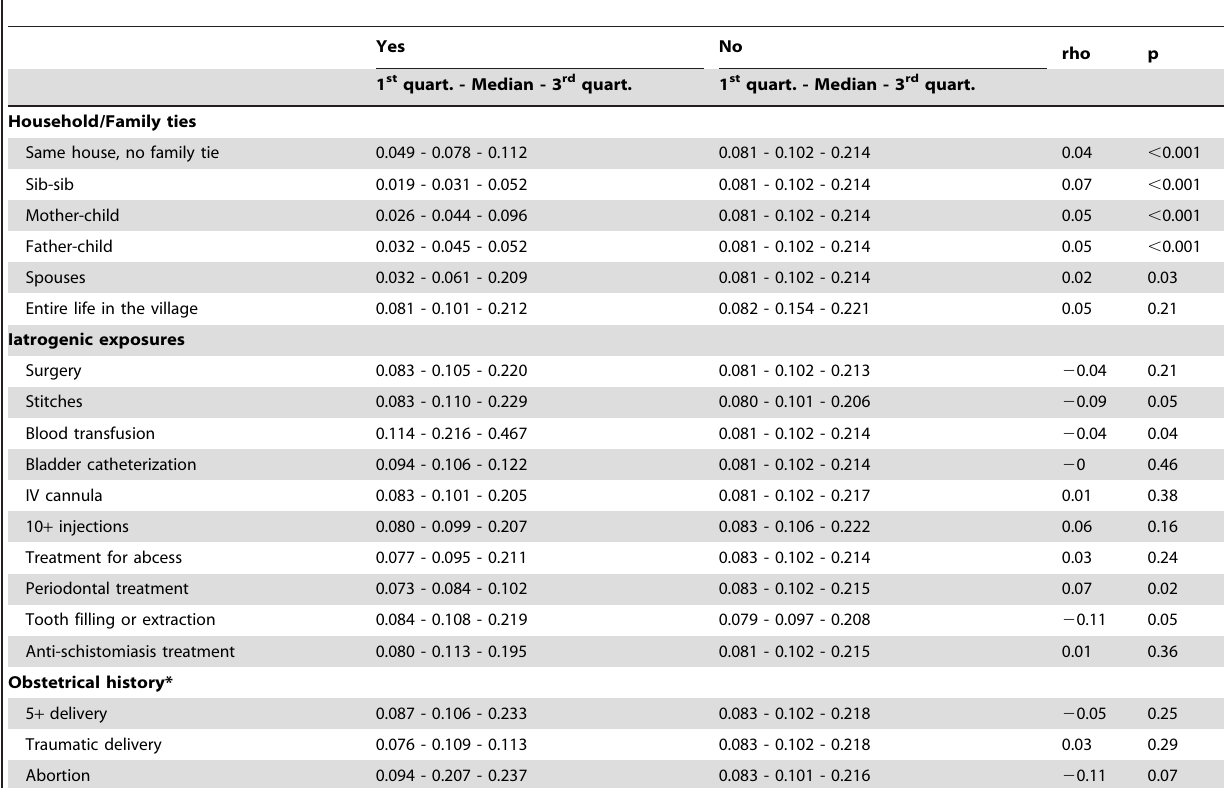
Table 2. Pairwise NS5b HCV genetic distances among 133 subjects according to common exposure